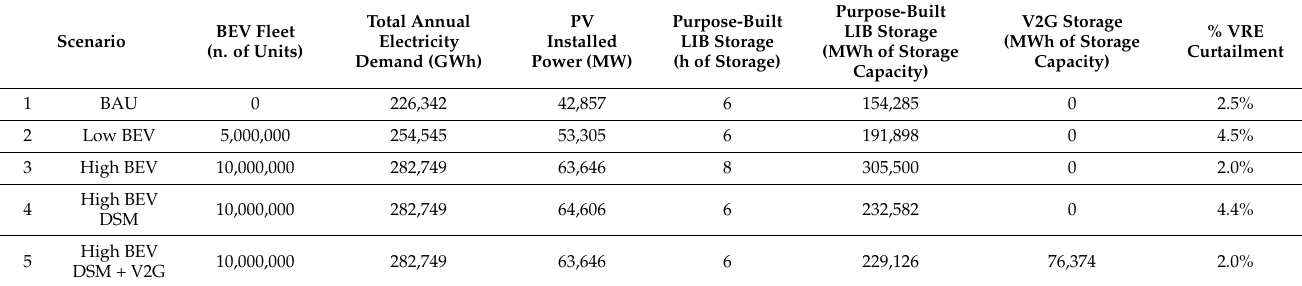
Table 1. Key parameters defining the five analysed scenarios for California in 2030.